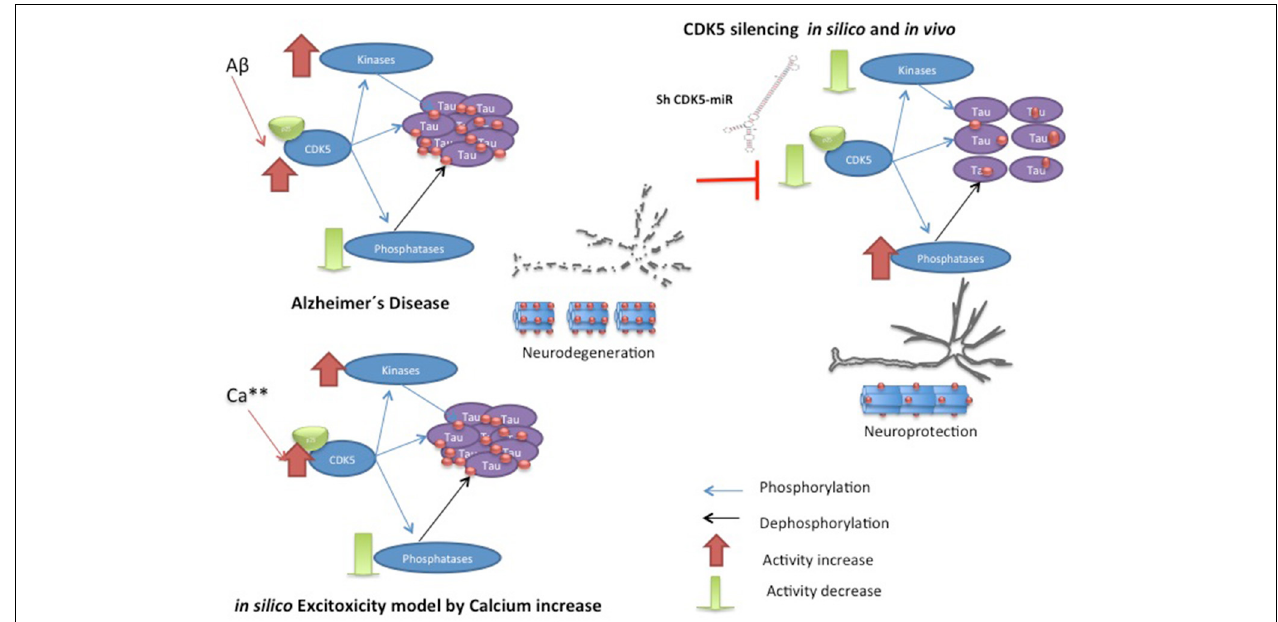
FIGURE 7 | Hypothetic model of CDK5 knockdown action on reversion of tauopathy in AD. The toxic events in AD induce imbalance between kinases and phosphatases, where CDK5 overactivation produce hyperphospholylation of Tau and neurodegeneration. Our in silico model can simulate it, when the